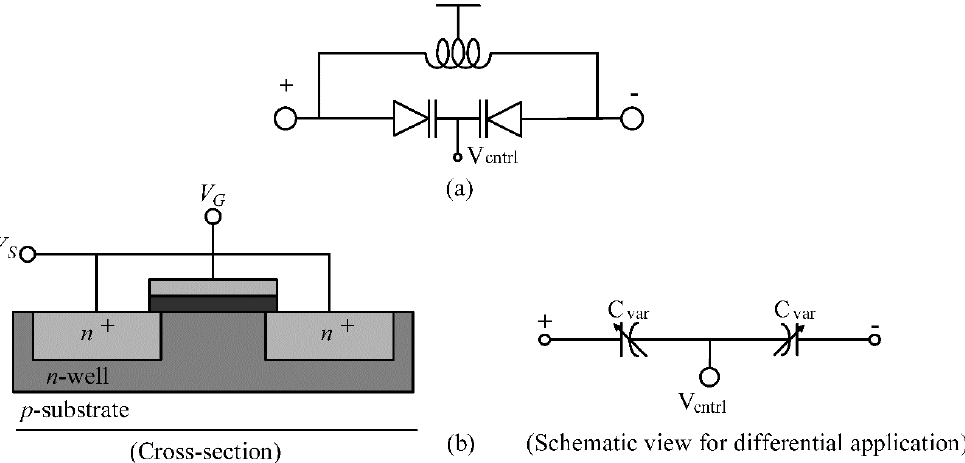
Figure 2. Schematics of ( a ) tank-coupled p-n diode, ( b ) n-type A-MOS varactor cross-section and its corresponding schematic view for differential applications. corresponding schematic view for differential